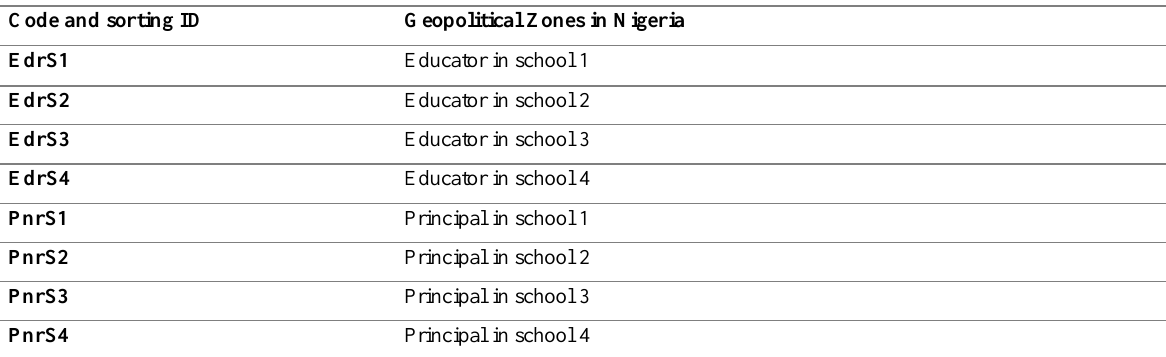
Table 1 : Coding, sorting and categorization of participants Code and sorting